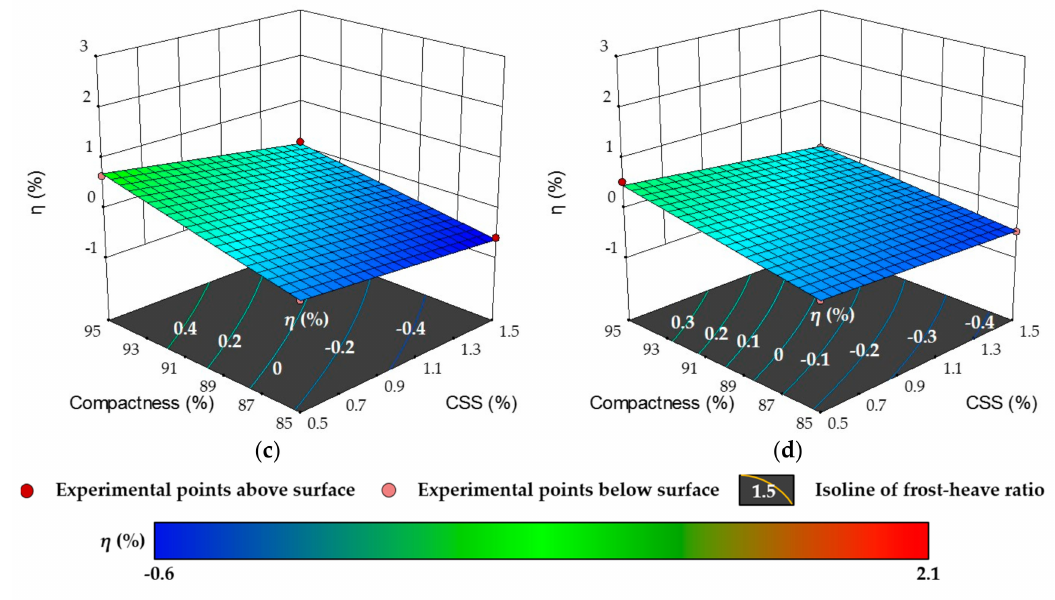
Figure 7. Three-dimensional surface plots of frost heave ratio response for compactness and CSS by ( a ) temperature − 25 ◦ C, water content 26%; ( b ) temperature − 4 ◦ C, water content 26%; ( c ) temperature − 25 ◦ C, water content 18%; and ( d ) temperature − 4 ◦ C, water content